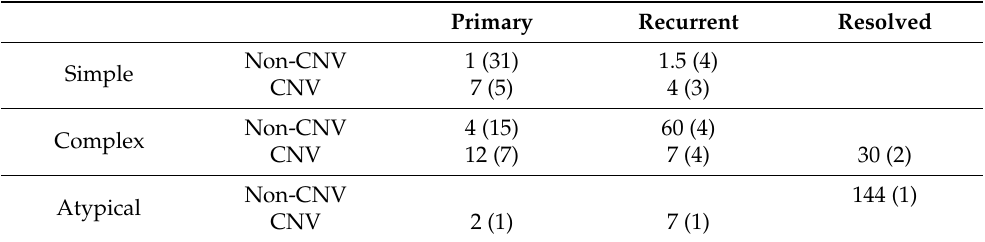
Table 5. Median Duration in Months of Central Serous Chorioretinopathy per Classification and presence of CNV